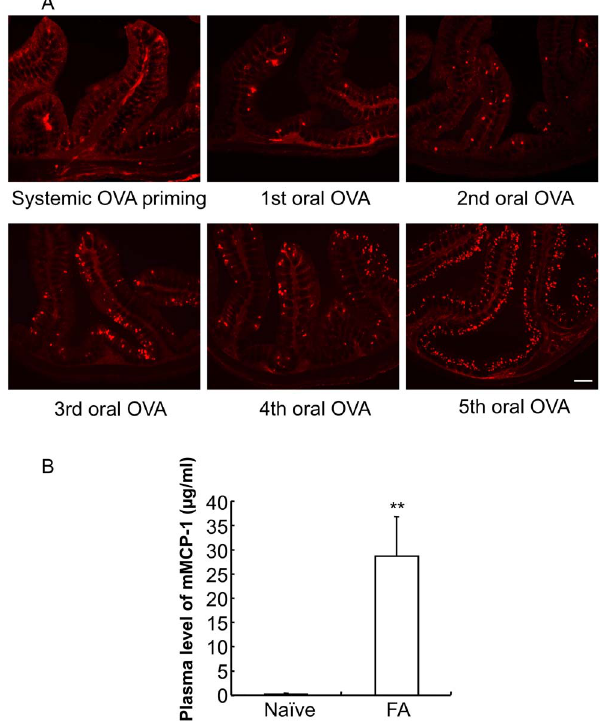
Figure 3. Mucosal mast cell hyperplasia and degranulation in the colon of food allergy mice. A : The proximal colons of systemically OVA primed mice and oral OVA-challenged mice after each oral OVA challenge were stained with anti-mouse mast cell protease-1 (mMCP-1) antibodies. Scale bar represents 200 m m. B : The concentration of mMCP-1 in the plasma of naı¨ve mice and FA mice is shown. The concentration of mMCP-1 in the plasma was determined using an ELISA kit. Data are expressed as means 6 SE. ** P , 0.01 vs. naı¨ve mice ( n =5 mice per group).